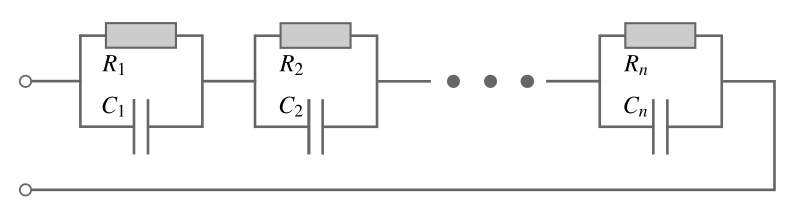
Figure 1. Foster-type RC-ladder network with n sections. Each section comprises a parallel resistance and capacitance.